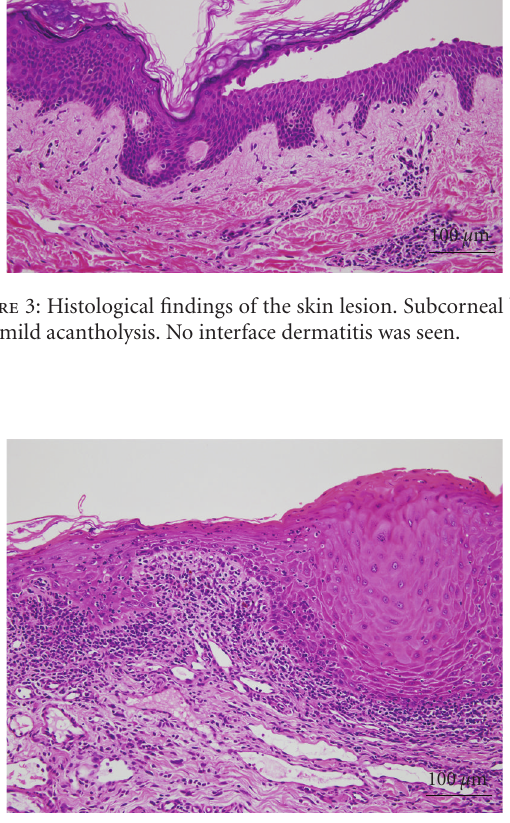
Figure 4: Histological findings of the oral lesion. Severe lichenoid dermatitis with dyskeratotic